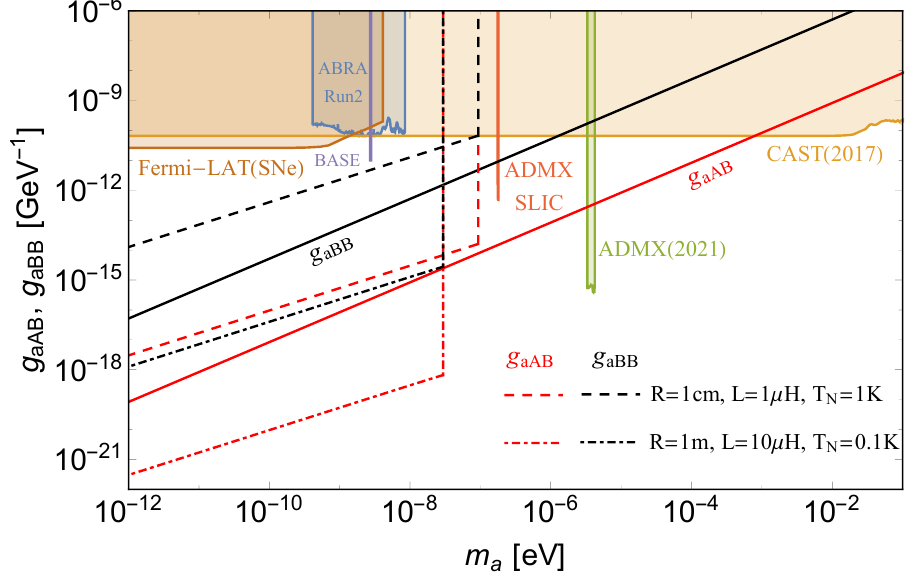
Figure 5 . The expected sensitivity bounds of g aAB (red lines) and g aBB (black lines). Two setup benchmarks of detector are assumed: R = 1 cm, L = 1 µ H, T N = 1 K (dashed) and R = 1 m, L = 10 µ H, T N = 0 . 1 K (dash-dotted). The theoretical predictions of g aAB and g aBB (solid) are also presented [33]. Some existing exclusion limits on g aγγ are shown for reference, including ABRACADABRA (Run 2) [36], CAST (2017) [51], ADMX (2021) [52], ADMX SLIC [37], BASE [39], and Fermi-LAT